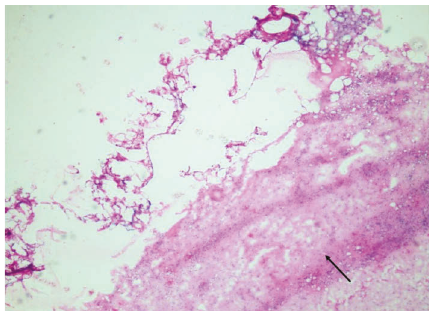
Figure 4: Freezing artifact: separation of adipose tissue and the painted surgical margin from fibrous tissue (arrow: fibrous tissue) (Frozen Section, x40; H δ E).